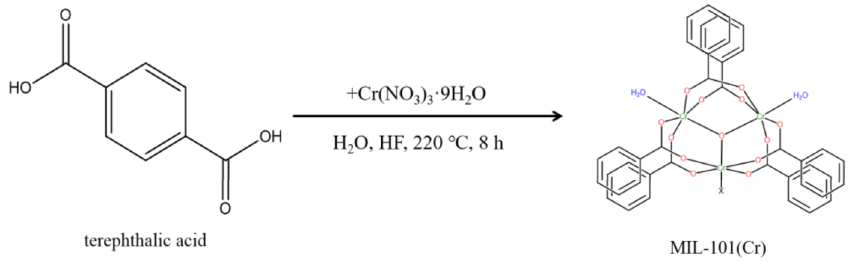
Figure 3. Hydrothermal synthesis process of MIL-101(Cr).